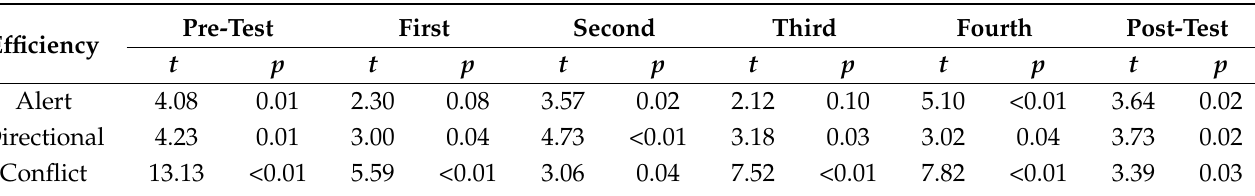
Table 1. t -test of ANT effects in INT